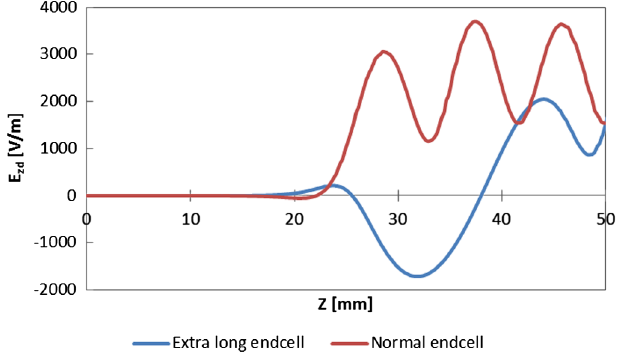
FIG. 16. Real part of the dipole field in the structure end section with and without extra-long cell for V